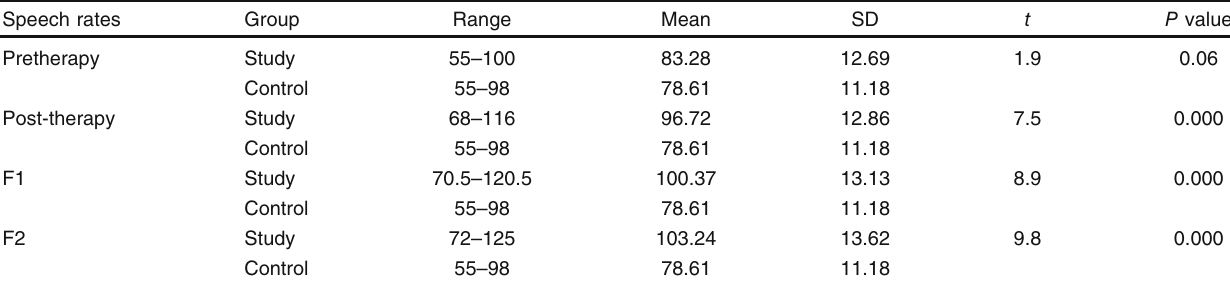
Table 4 Comparison between the study group and the control group as regards speech